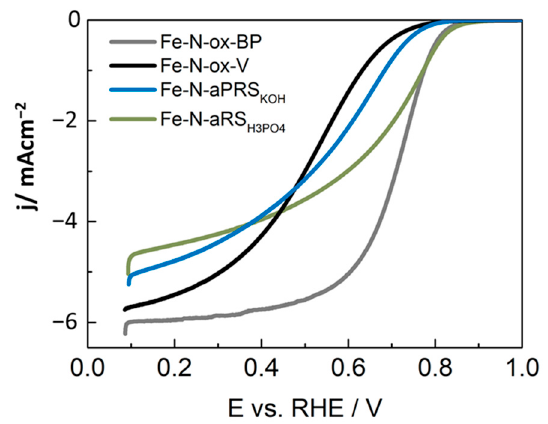
Figure 9. Linear sweep voltamogramms of the four Fe-N-C catalysts with a loading of 400 µg/cm² at a rotation speed of 1600 rpm in O 2 -saturated 0.1 M HClO 4 electrolyte.